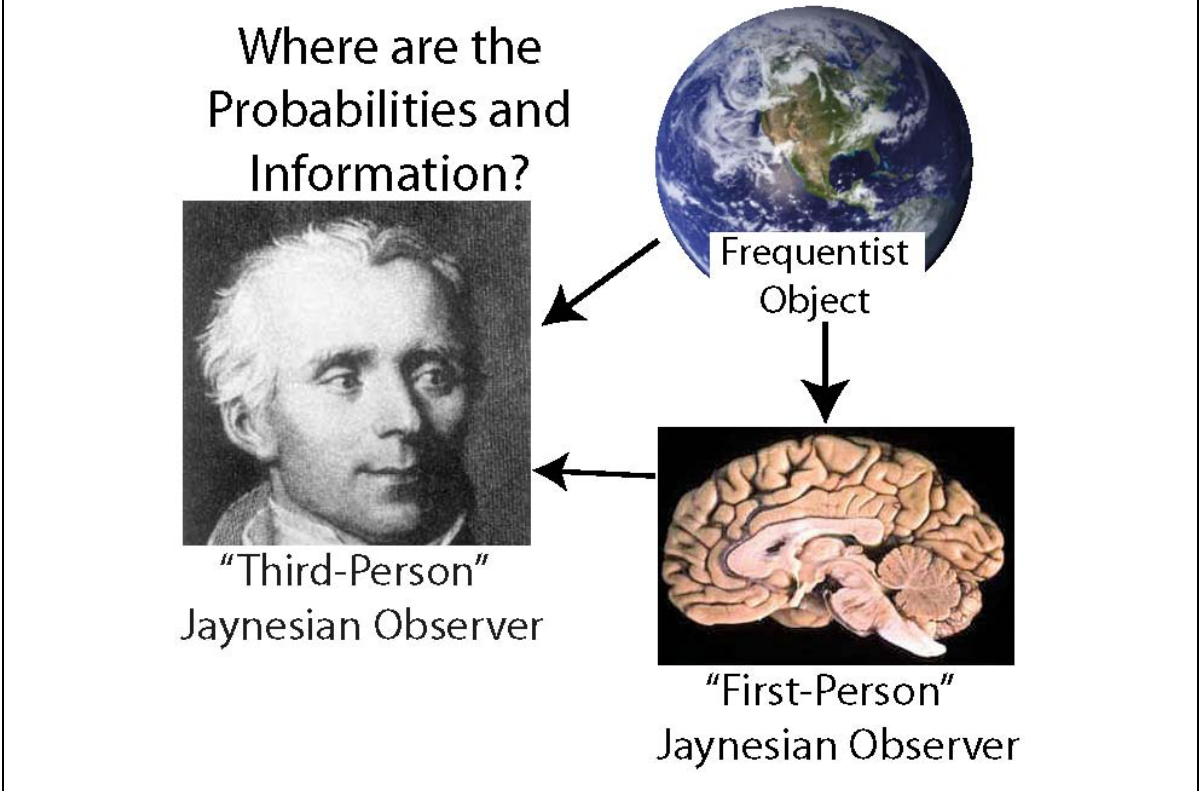
Figure 1. Are the information and probabilities used in neuroscience properties of the environment (an observed object), the neural system under investigation, or the scientist? The frequentist view is that probabilities are a property of a physical system (or object) that generates frequency distributions, and they exist independent of any observer of that system. The physical system could correspond to a neural system or anything else. Here I argue in favor of the view of Jaynes (and Laplace, shown at left) that probabilities are always conditional on the information of an observer about an object. I presume that the observer’s information must be in a physical form inside the observer. There could be many observers, but in neuroscience, the observer of interest would usually correspond either to the scientist (who observes a neural entity as well as its environment from a “third-person” perspective), or to the neural entity under investigation (for example, a brain, neuron or ion channel, which observes its environment from its “first-person” perspective). The arrows indicate the typical direction of information flow. The distinction between “observer” and “object” is merely one of perspective, and does not imply any fundamental distinction between the qualities of the two. Are Probabilities Properties of Observers or